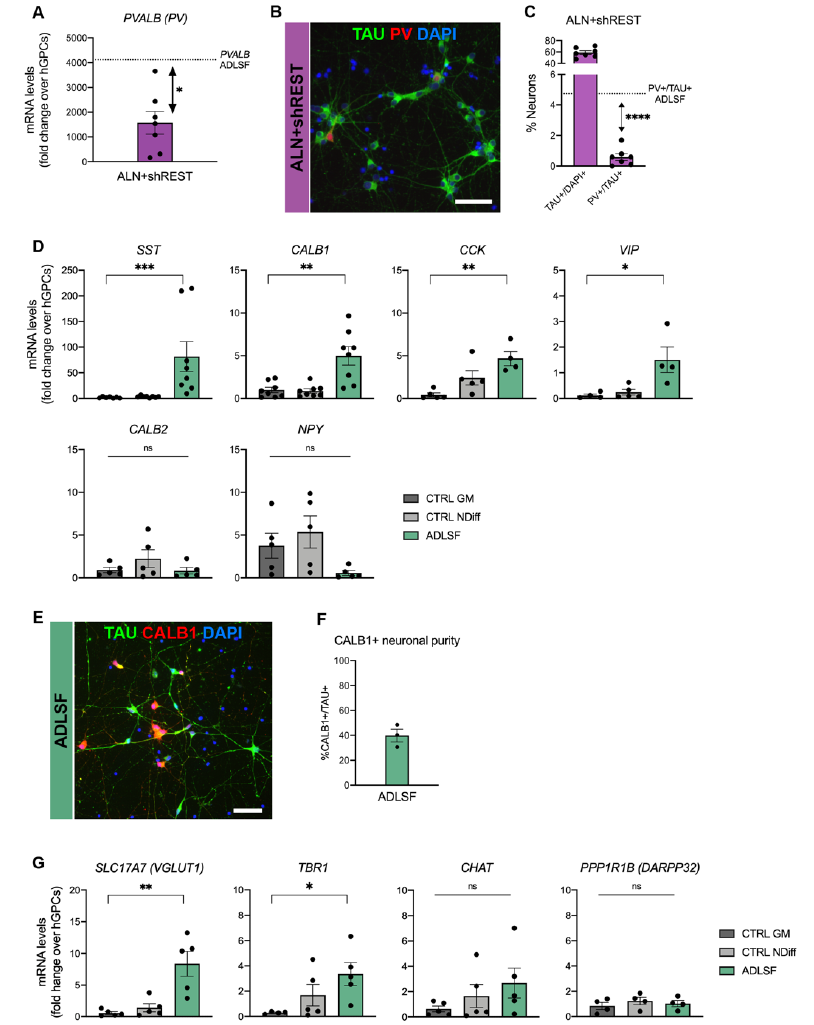
Figure 4. iNs display molecular properties of interneurons at day 26 after transduction. ( A ) RT-qPCR analysis of PVALB gene expression in ALN + shREST reprogrammed neurons and comparison with ADLSF. Two-tailed unpaired t-test with Welch´s correction (n = 7 for ALN + shREST): * p = 0.025; df = 15; dashed line represents mean average of PVALB mRNA levels in ADLSF condition (see Figure 2A). ( B , C ) TAU + and PV + /TAU + cells in ALN + shREST reprogrammed neurons, ( B ) immunocytochemistry, and ( C ) quantification with comparison to ADLSF. Two-tailed unpaired t-test with Welch´s correction (n = 7 for ALN + shREST): **** p < 0.0001; df = 12.07; dashed line represents mean average of PV + /TAU + cells in ADLSF condition (see Figure 2F). ( D ) RT-qPCR analysis of ADLSF reprogrammed cells showing upregulation for subtype-specific GABAergic interneuron markers. Kruskal-Wallis test, Dunn’s multiple comparisons test (n = 4–8 for CTRL GM, n = 5–8 for CTRL NDiff, n = 4–8 for ADLSF): *** p < 0.005; ** p 0.01; * p < 0.05; ns, not significant. ( E , F ) Reprogrammed CALB1 + /TAU + (n = 3) at 26 days post transduction, ( E ) immunocytochemistry, and ( F ) quantification. ( G ) RT-qPCR analysis of different neuronal lineage markers in ADLSF-reprogrammed cells. Kruskal–Wallis test, Dunn’s multiple comparisons test (n = 4–5 for CTRL GM, for CTRL NDiff and ADLSF): ** p < 0.01; * p < 0.005; ns, not significant. Data are presented as mean ± SEM. Each datapoint represents a replicate from an independent experiment. Scale bar: ( B , E ) 50 µm.